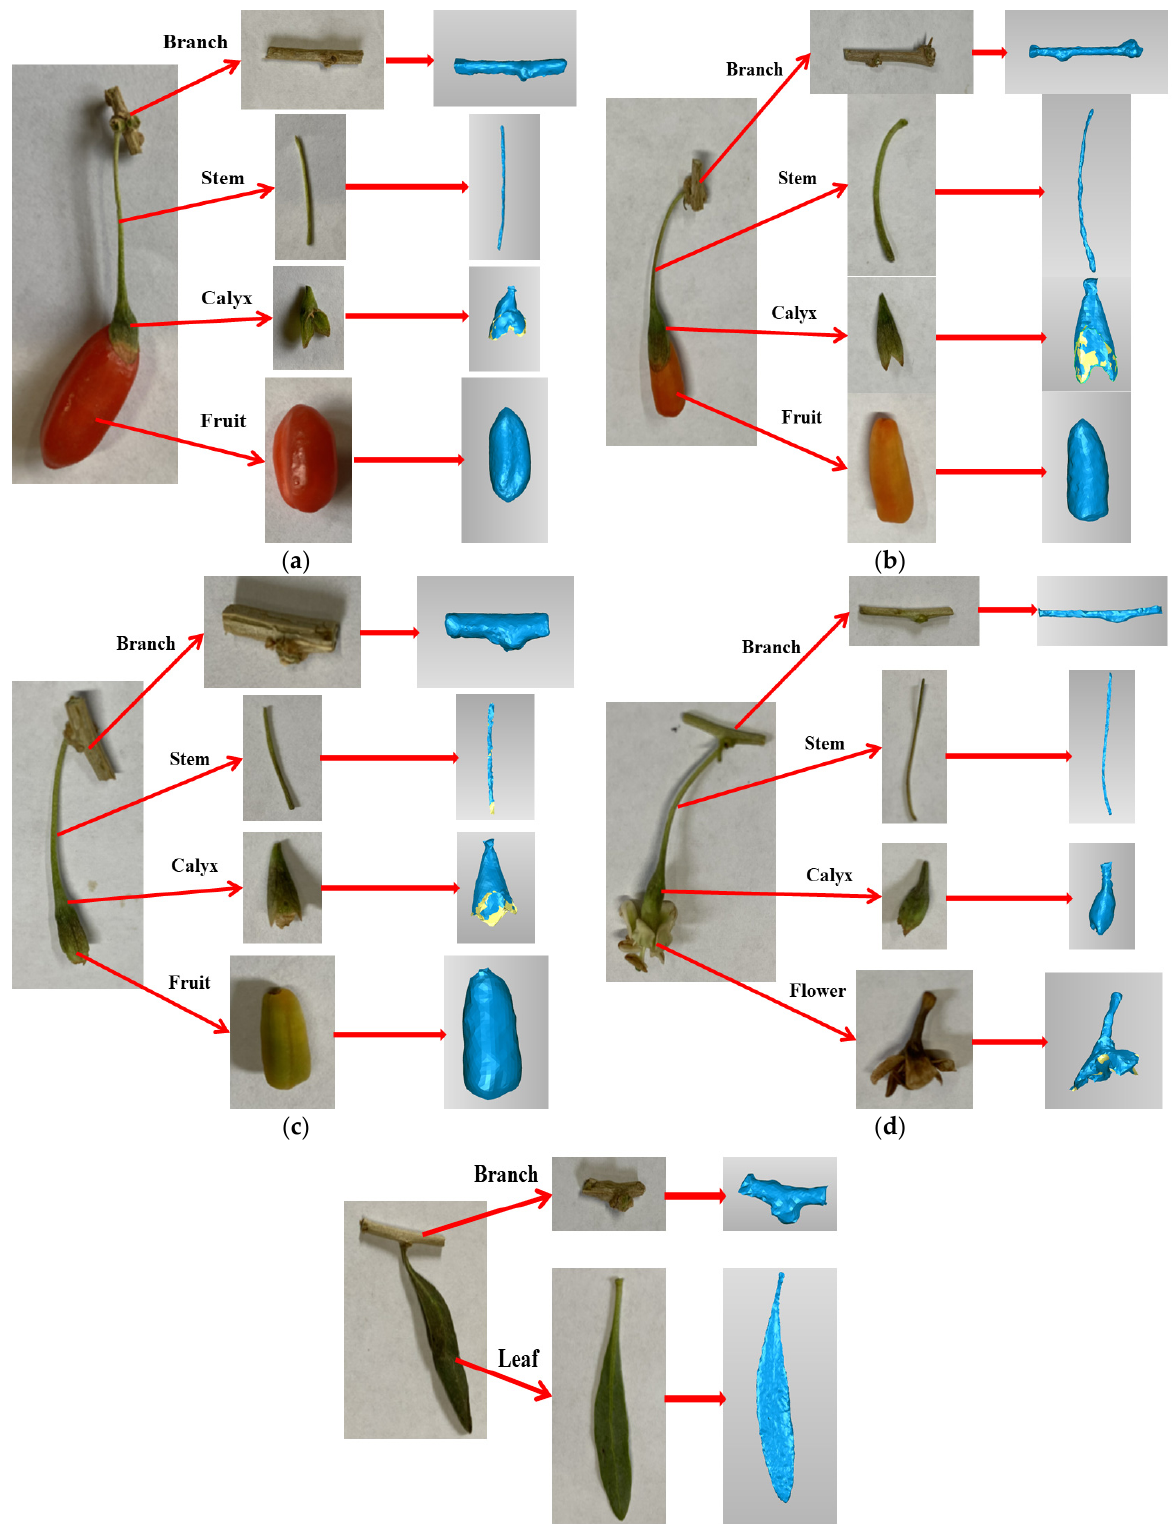
Figure 1. The photos and 3D models of the ripe fruit ( a ), half-ripe fruit ( b ), unripe fruit ( c ), flowers ( d ), and leaves ( e ).